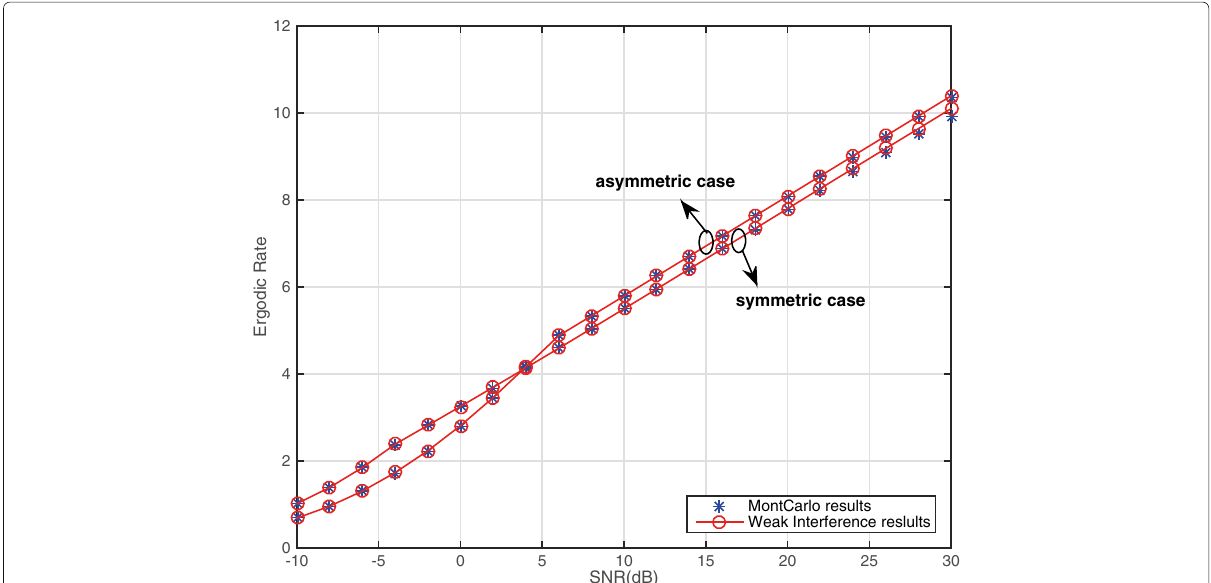
Fig. 4 Weak interference approximations and Monte-Carlo simulated ergodic rate against SNR for both asymmetric and symmetric